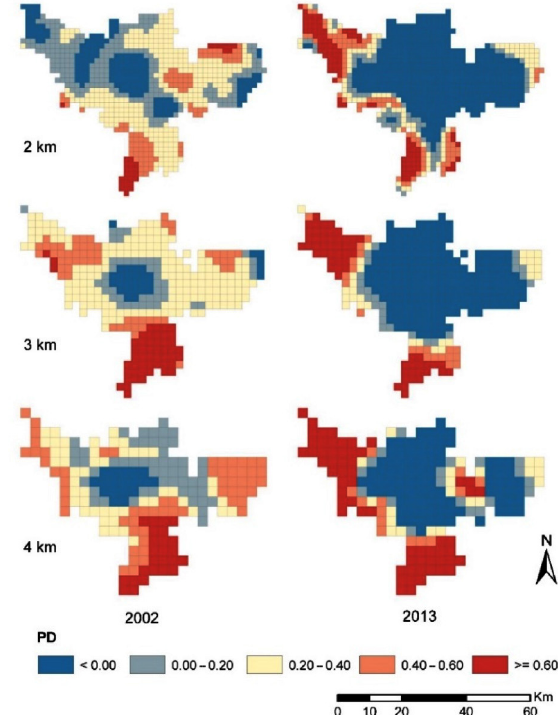
Figure 6. Spatial distributions of the correlation coefficients obtained from GWR for PD at three scales (2 km, 3 km, and 4